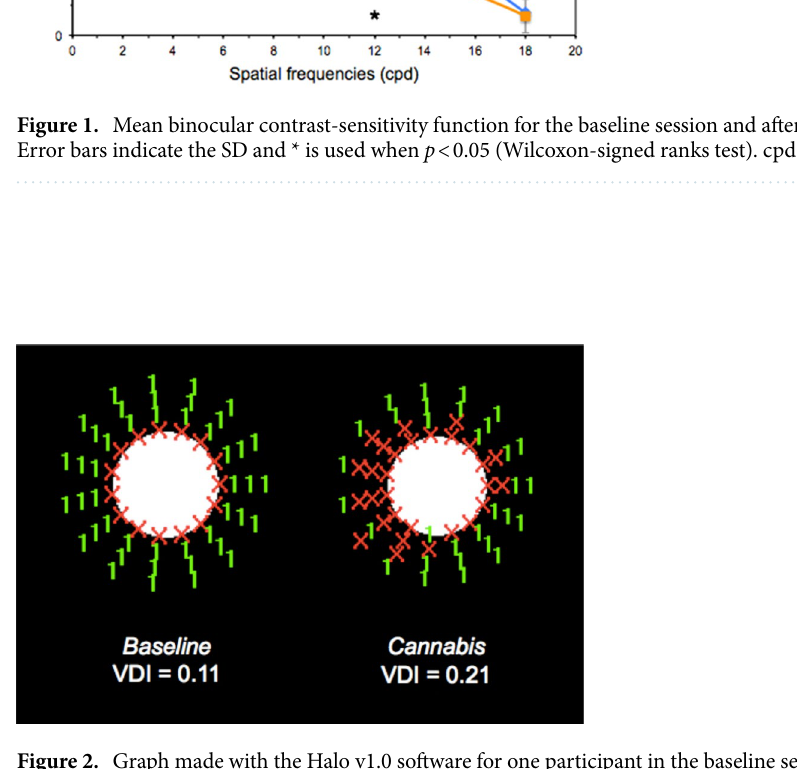
Figure 2. Graph made with the Halo v1.0 software for one participant in the baseline session and after smoking cannabis. VDI value is included. (Pupil size was 5 mm for both